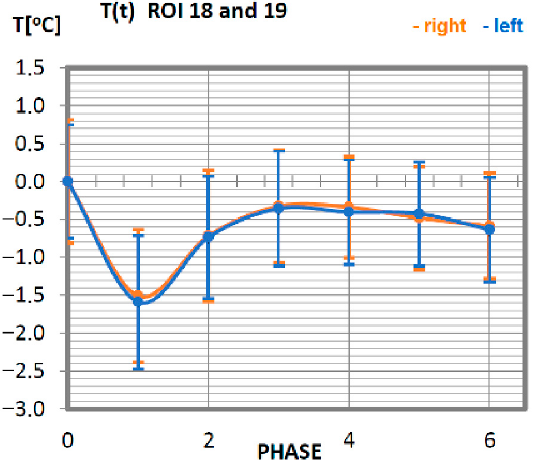
Figure 10. Temperature time (0 to 6 phase of training according to methods) changes of the quadriceps muscle obtained before and after training using a rowing ergometer for the studied group of athletes.